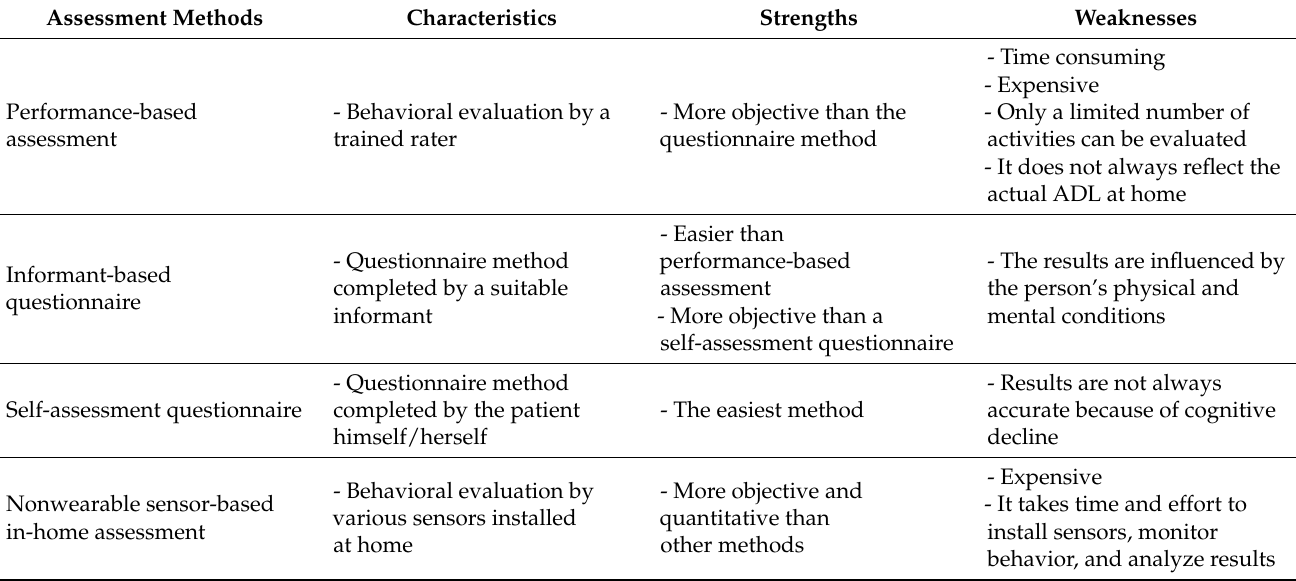
Table 1. Assessment methods for daily behavioral patterns in patients with MCI and